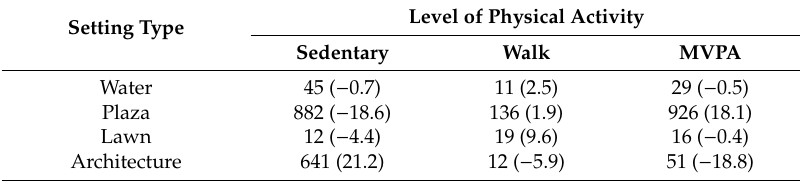
Table 5. Cross tabulation of setting type and level of physical activity.